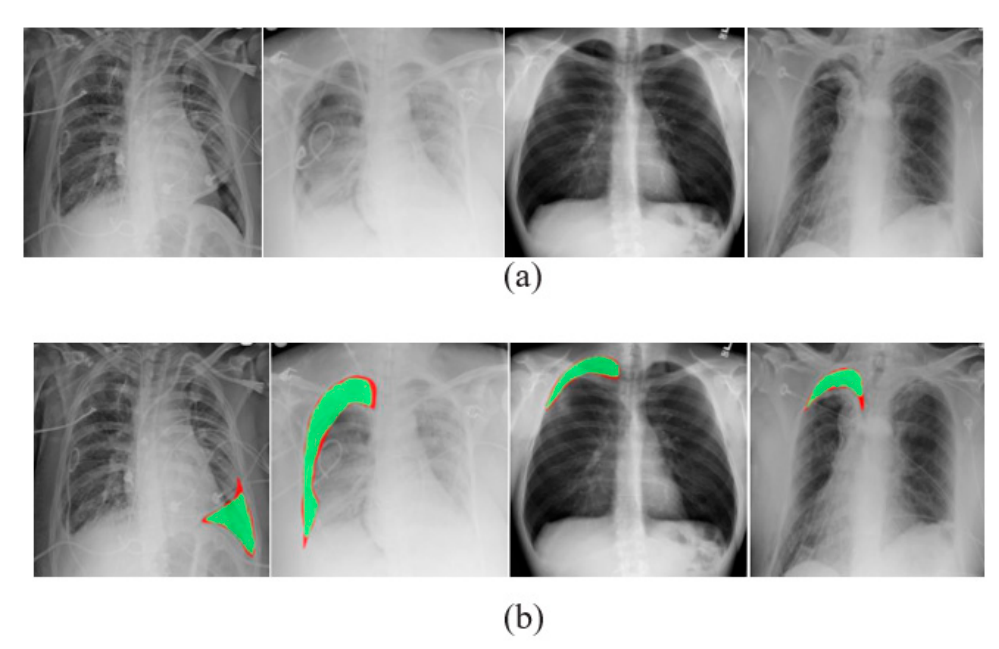
Figure 6. ( a ) Visually identified pneumothorax and ( b ) pneumothorax identified in X-ray images by PneumoNet.